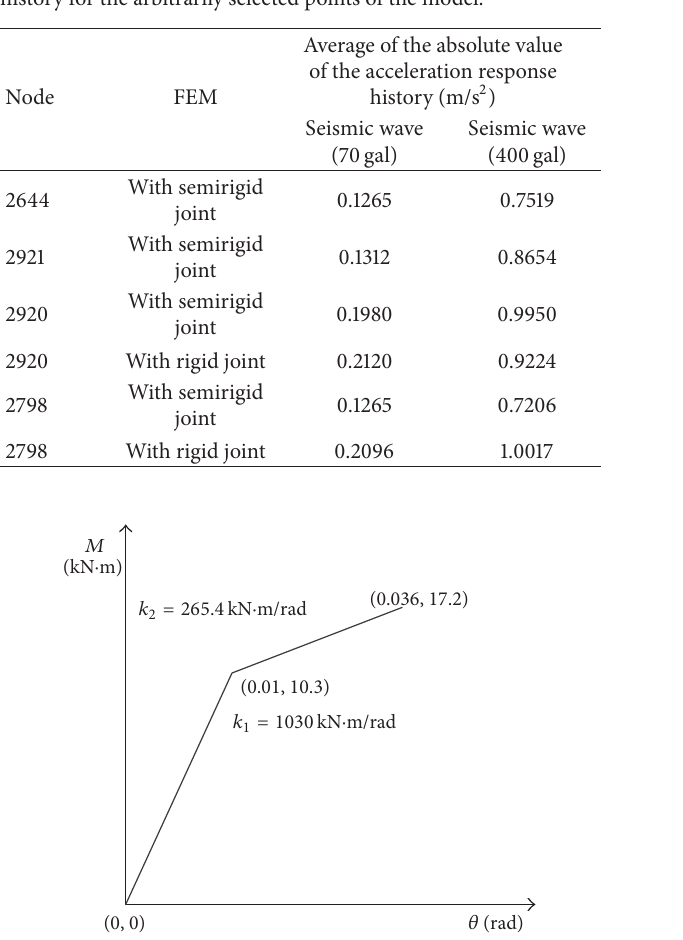
Table 1: Average of the absolute value of the acceleration response history for the arbitrarily selected points of the model.